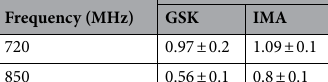
Fraction recombination +EMF/−EMF (EMF at S ≈ 1.5 µW/cm 2 )